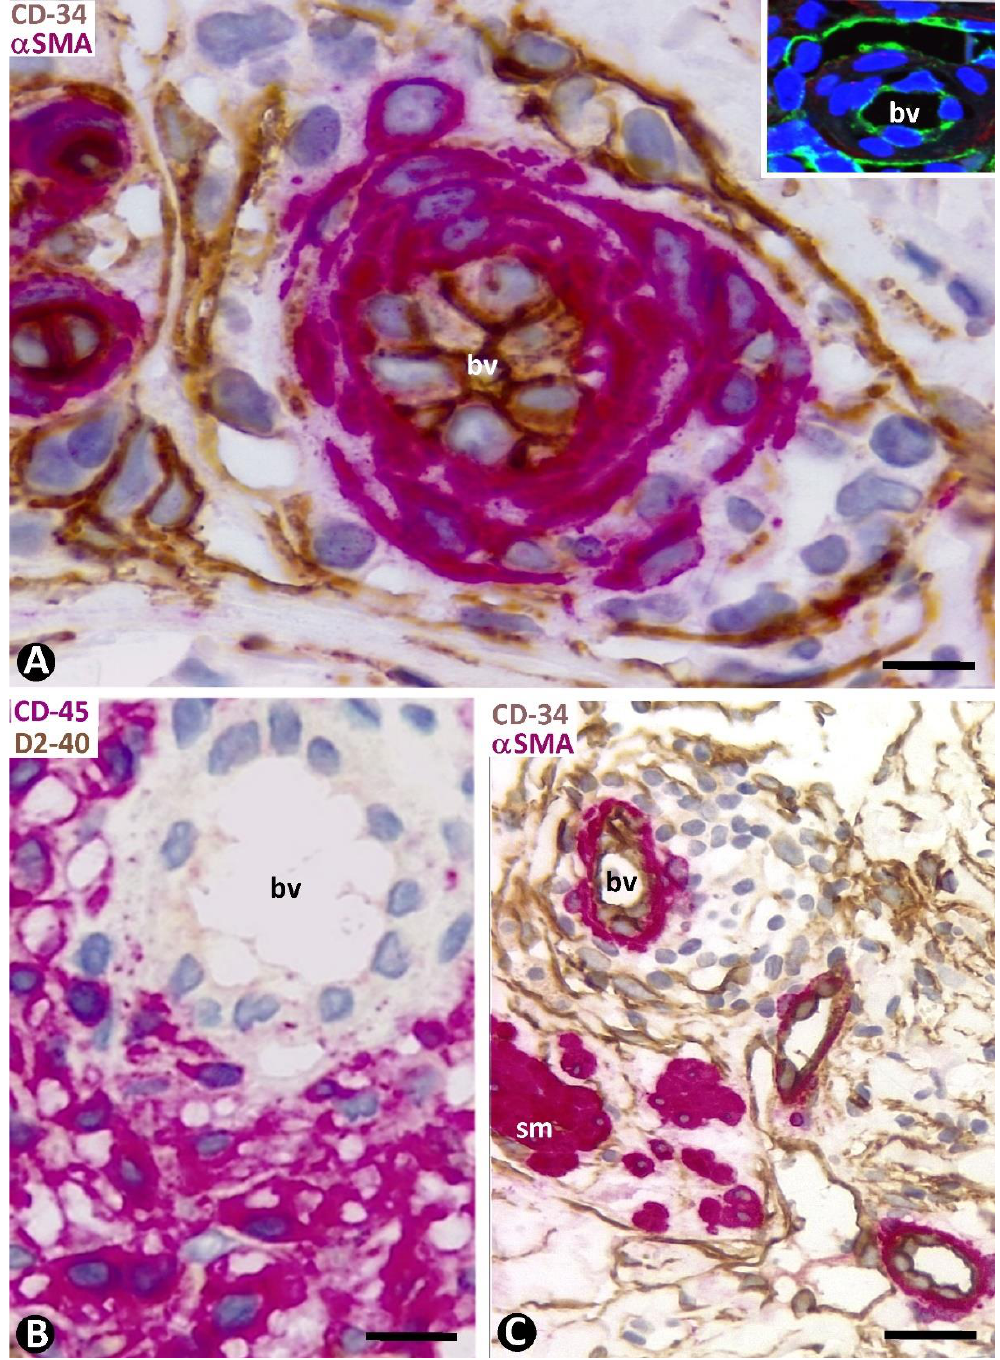
Figure 4. Pre-existing blood vessels with perivascular inflammatory infiltrate. ( A ): Inflammatory cells are observed between CD34+SCs/TCs (brown) and mural cells (red), respectively, located in the external and media layer of a pre-existing blood vessel (bv). In the insert, a similar image is in immunofluorescence for CD34. ( B ): Expression of CD45 by the inflammatory cells (red). ( C ): Perivas- cular inflammatory infiltrate like that of A, in a complex structure (presence of smooth muscle red, sm). ( A , C ): Double immunochemistry for CD34 (brown) and α SMA (red). Hematoxylin counterstain. Insert in ( A ): Immunofluorescence for CD34. DAPI counterstain. ( B ): Double immunochemistry for CD45 (red) and D2-40 (not expressed). Hematoxylin counterstain. Bar: ( A ): 10 µ m; ( B ): 20 µ